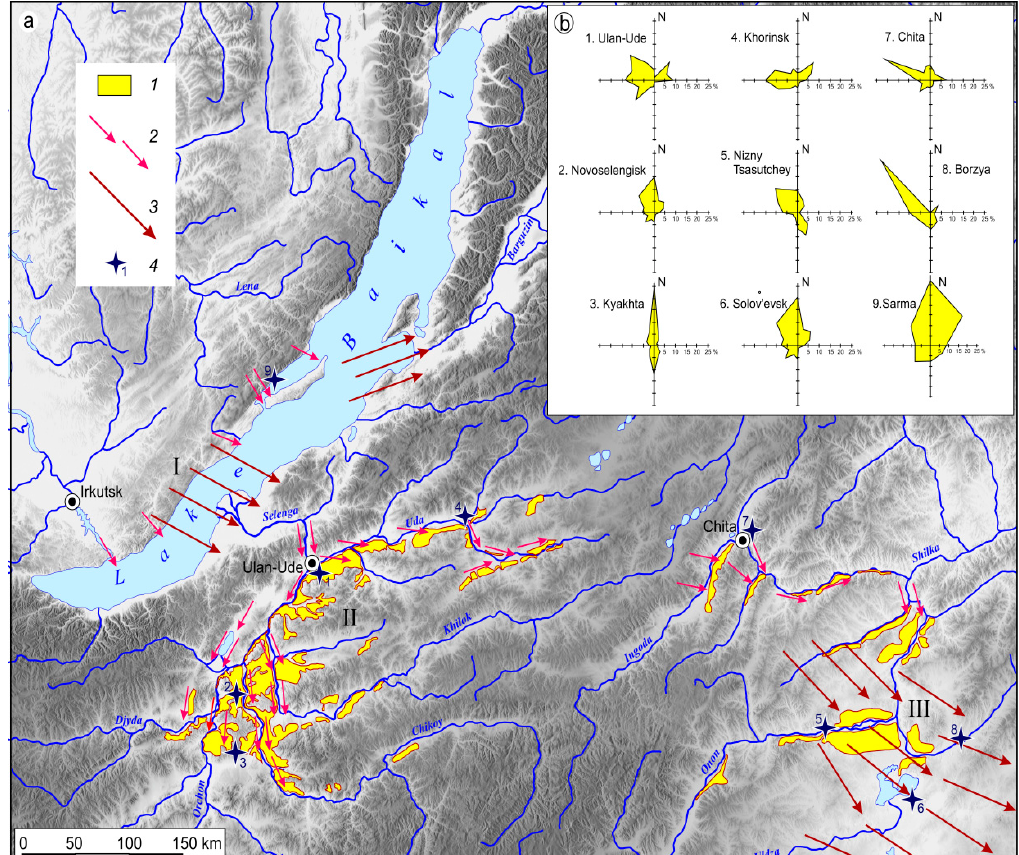
Figure 1. Distribution of aeolian sediments and main streams of aeolian matter transfer in the territory of Transbaikalia ( a ): 1—areas occupied by aeolian, aeolian-deluvial, and aeolian-proluvial sediments; 2—main wind corridors in depressions, river valleys; 3—extensive wind corridors over the plains and water surfaces of large bodies of water; 4—weather stations and their number; districts: I—Baikal’skii, II—Selenginskii, III—Daurskii; ( b )—average annual wind roses of weather stations (numbers correspond with the diagram).